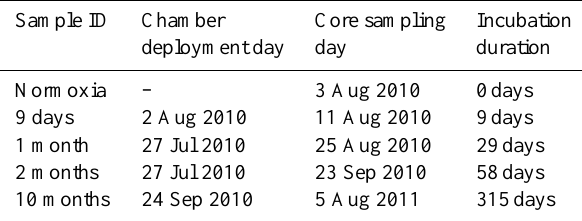
Table 1. Deployment and sampling dates as well as duration of the experimental period for the cores representing in situ conditions (“Normoxia”) and the various periods of anoxia in the four different benthic